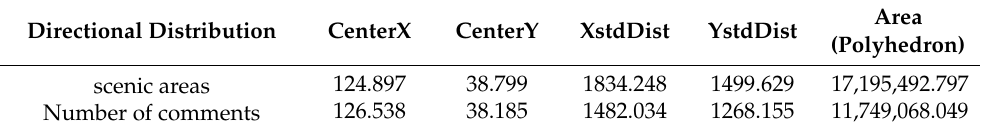
Table 3. Landscape distribution and tourist distribution standard deviation ellipse parameters.